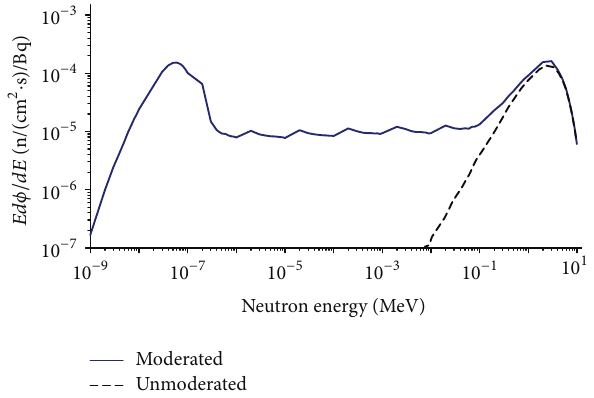
Figure 9: Calculated neutron spectrum within the sample chamber with and without the pure and borated polyethylene